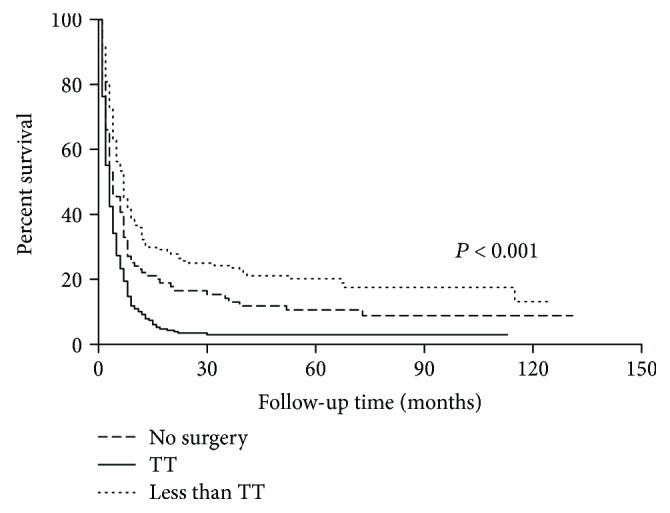
Surgery of the primary tumor site significantly improved the overall survival. Patients treated with total/near-total thyroidectomy (TT) showed superior survival compared with less than TT group and no-surgery group (P < 0.001).